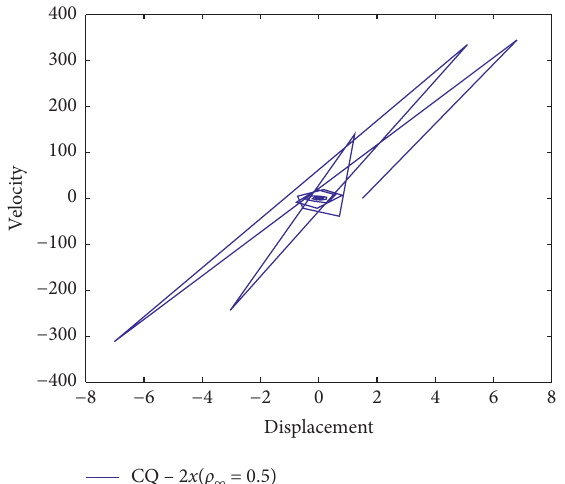
Figure 25: Phase portrait of the hardening spring calculated using CQ-2 x ( ρ